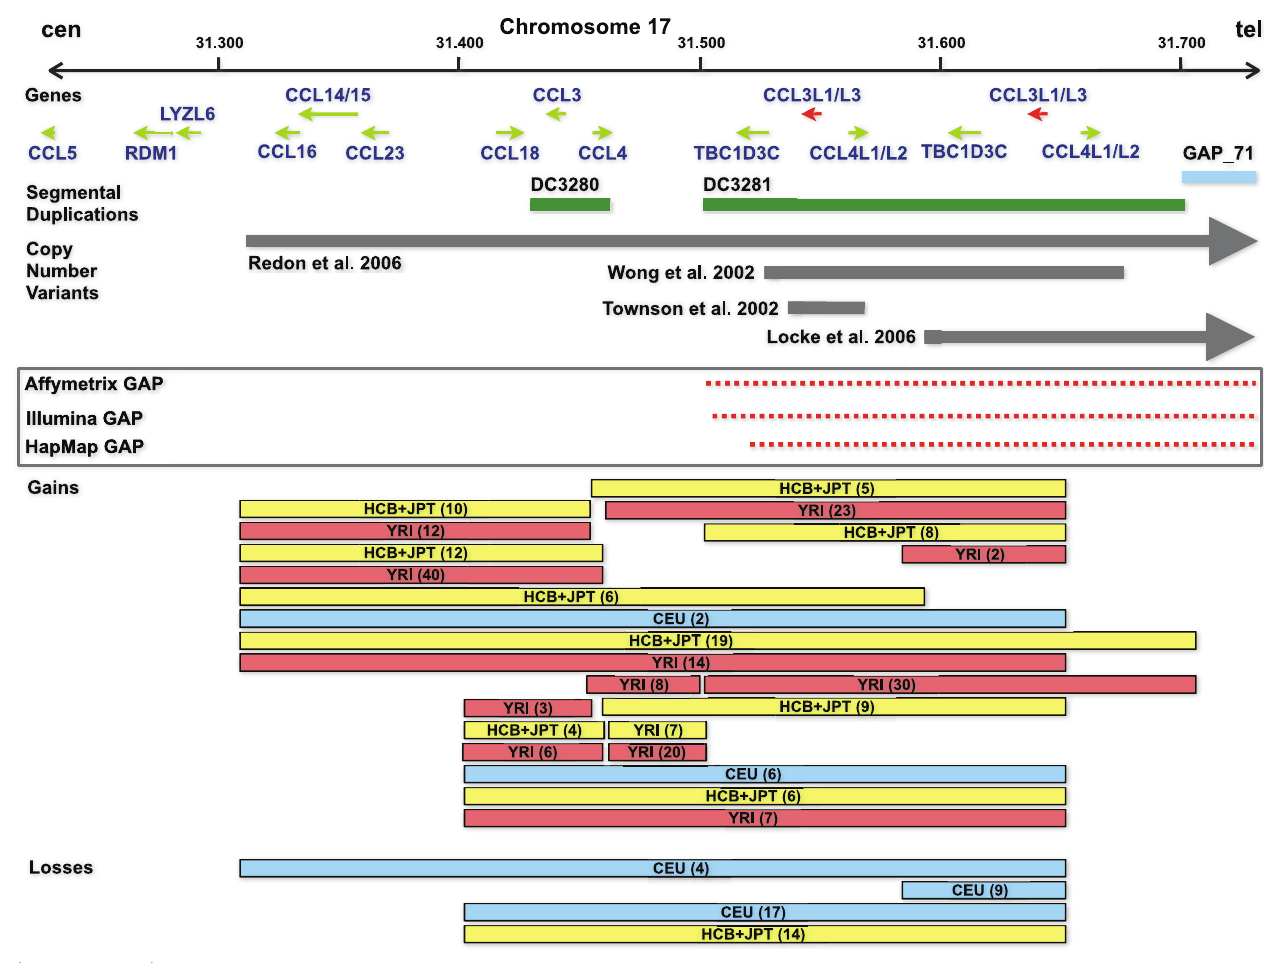
Figure 4. Genomic Organization of the Chemokine Cluster on Human Chromosome 17, Containing the CCL3L1 Gene (Red Arrows), Which Shows Variability in Copy Number and Association to HIV-1 Infectivity and AIDS Susceptibility This region contains several segmental duplications and has been reported to vary in copy number in several studies. The Affymetrix 500K and Illumina HumanHap 550 arrays do not cover this region well, and completely lack SNPs in the CCL3L1/L3 gene (red dotted lines). A large number of gains and losses have been reported in the HapMap samples. Numbers in parentheses indicate the number of events involving genomic changes. CEU, European; HCB, Chinese; JPT, Japanese; YRI, African.